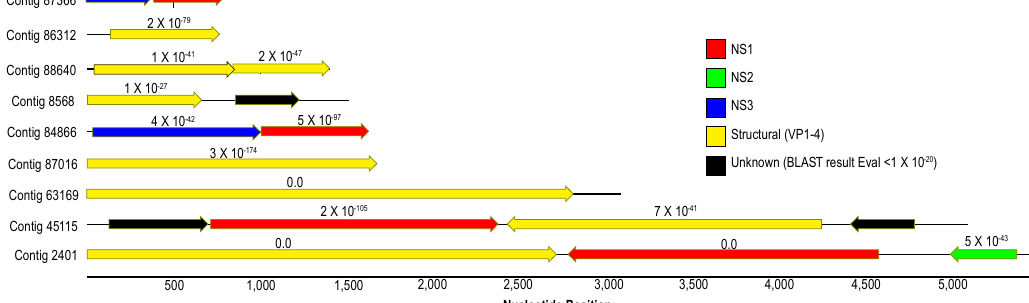
Figure 6. Map of densovirus-like genome fragments recovered from Pisaster ochraceus from Davenport, CA in July 2018. The length of contig is given by the solid black line running through open reading frames (ORFs; indicated by arrows). The color of arrow indicates the top BLASTx match to the non-redundant database at NCBI, and e -value of the match given above each ORF.